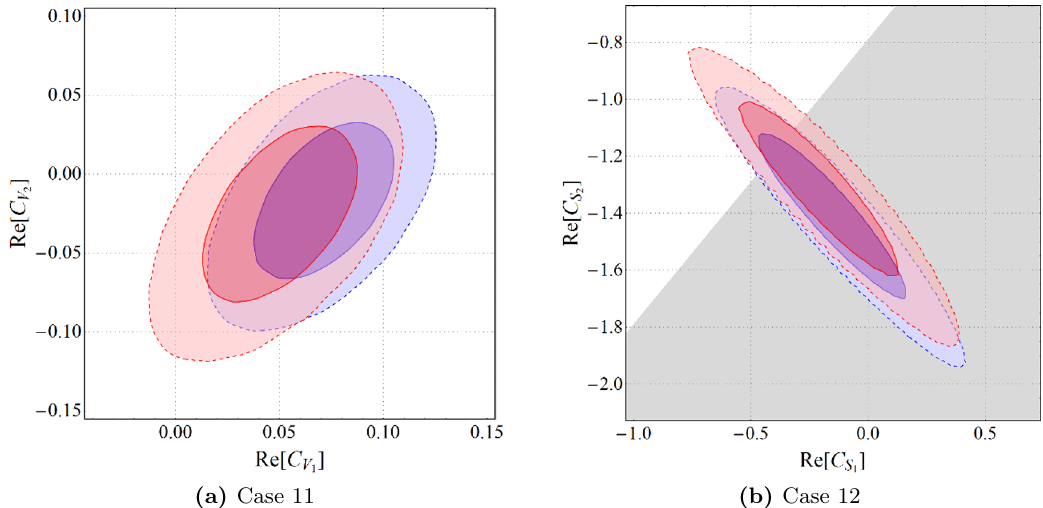
Figure 6. Allowed NP parameter space for the multi-modal new physics scenarios, with the small- est absolute values for the WCs. The blue regions correspond to the NP (cid:12)ts to all the experimental inputs in table 7 while the red ones correspond to the (cid:12)ts with BaBar data dropped. Solid and dashed contours enclose 68% and 95% highest probability regions respectively. The gray shaded regions denote the NP parameter space disallowed by B ( B c ! (cid:28)(cid:23) (cid:28) ) > 30%.